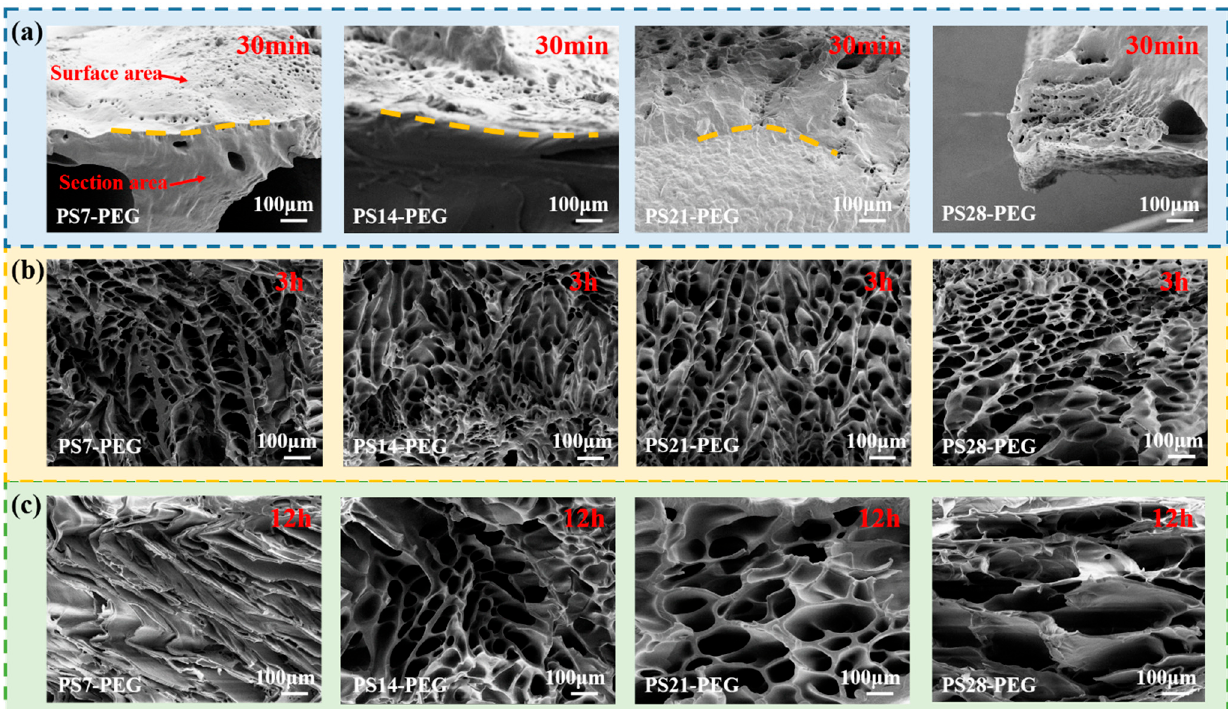
Figure 11. Fracture morphology of the NQFDH samples: ( a ) 30 min, ( b ) 3 h, ( c ) 12 h.